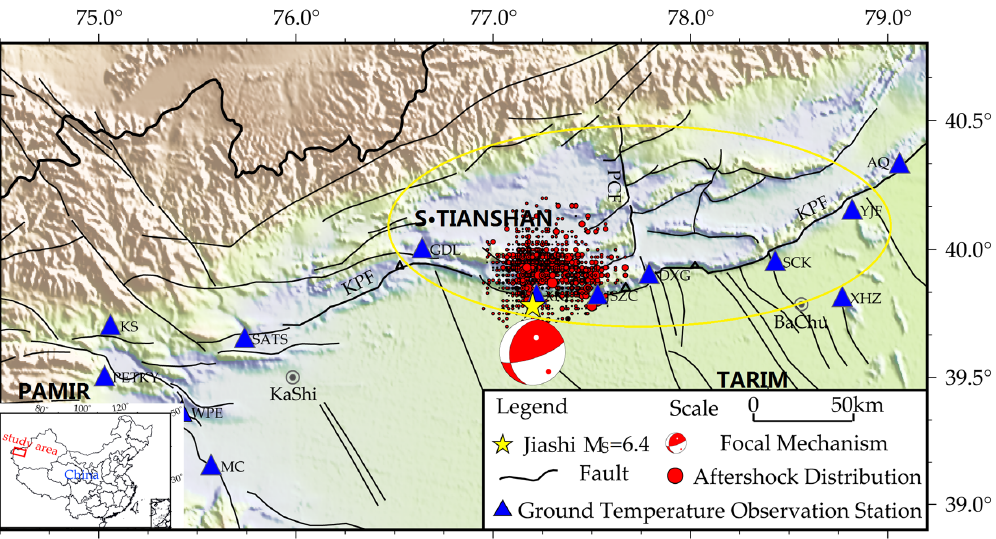
Figure 1. General situation of Jiashi Ms = 6.4 aftershock sequence area and distribution of ground temperature observation stations. KPF: Keping fault.